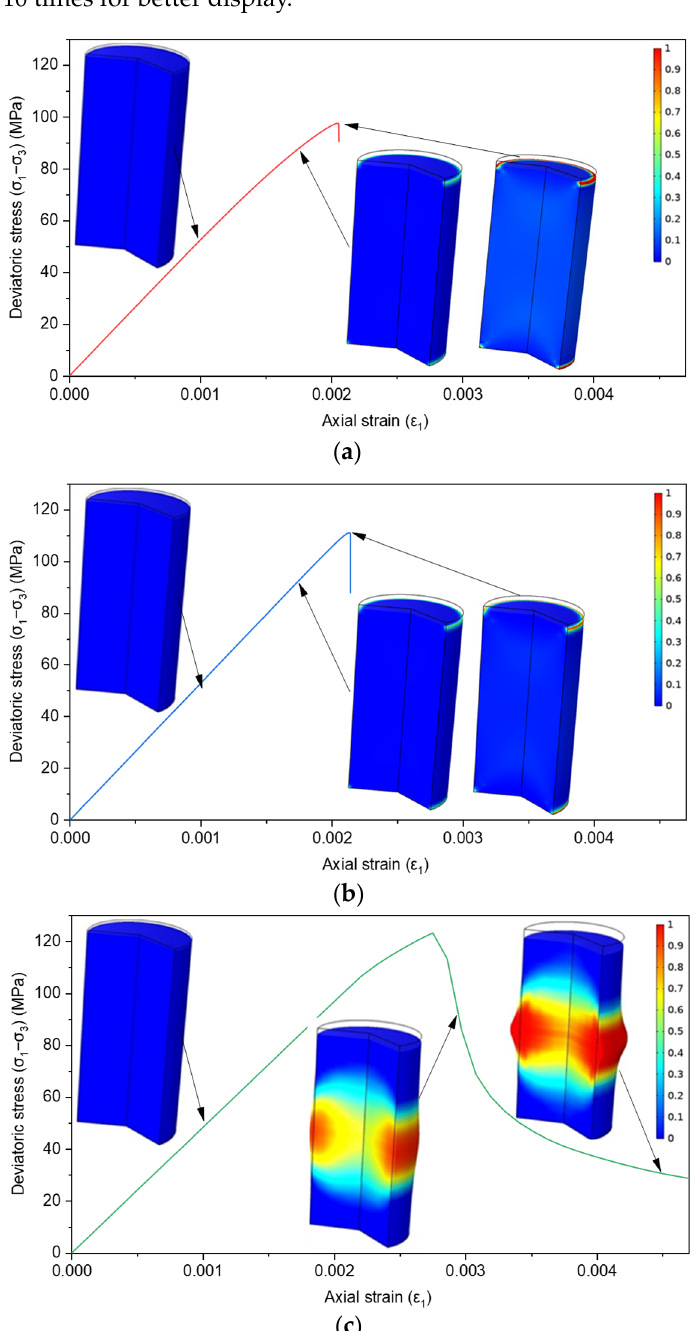
Figure 7. The damage distribution and evolution of different models under ununiform stress con– ditions: ( a ) the empirical damage model; ( b ) the statistical damage model; and ( c ) the elastoplastic damage model.